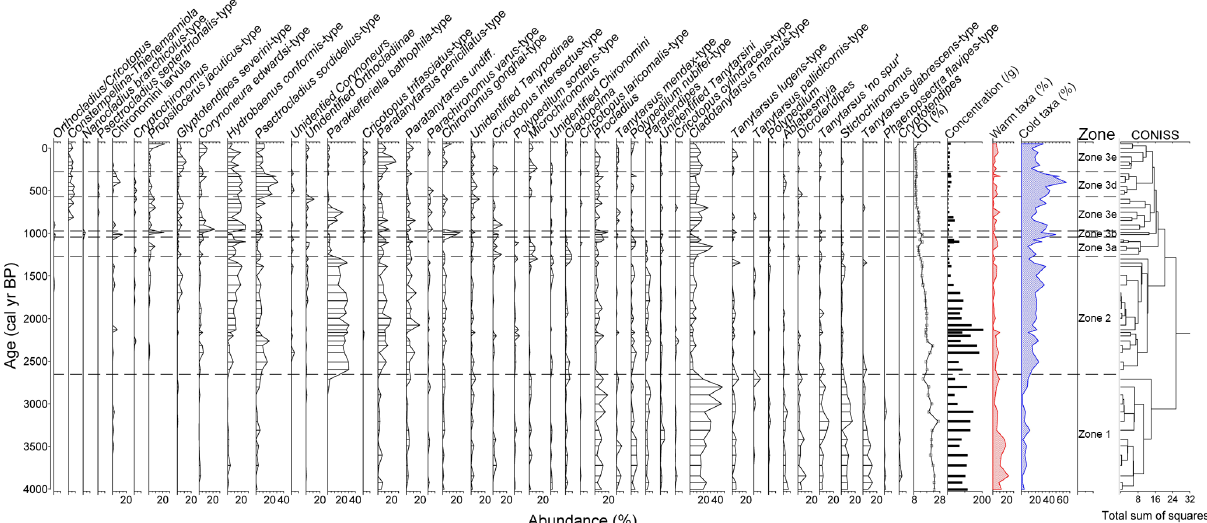
Figure 4. Relative abundance of the main chironomid taxa from Gonghai Lake during the past 4000 years. Taxa are plotted from left to right in order of their DCA 1 scores. Loss-on-ignition (LOI) values, chironomid concentration and percentages of warm- and cold-preferring taxa are plotted as black line with squares, black bars and red and blue patterns, respectively. Three chironomid assemblage zones were defined by CONISS results.